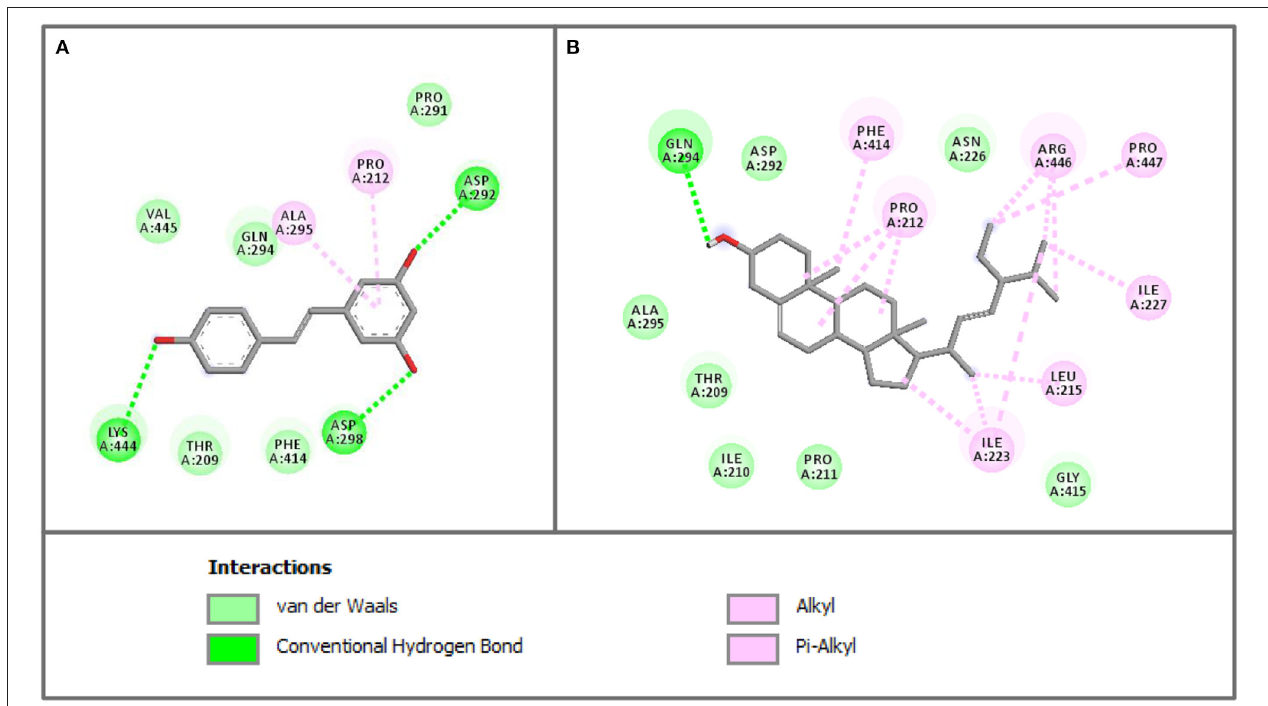
FIGURE 5 | The 2D interaction profiles of resveratrol (A) and stigmasterol (B) in SIRT1 activator binding site (PDB ID 5BTR). The 2D structures of the compounds are shown via the gray line, interacting residues are represented as colored circles according to the type of interactions (2D diagram generated by Discovery Studio 4.5).